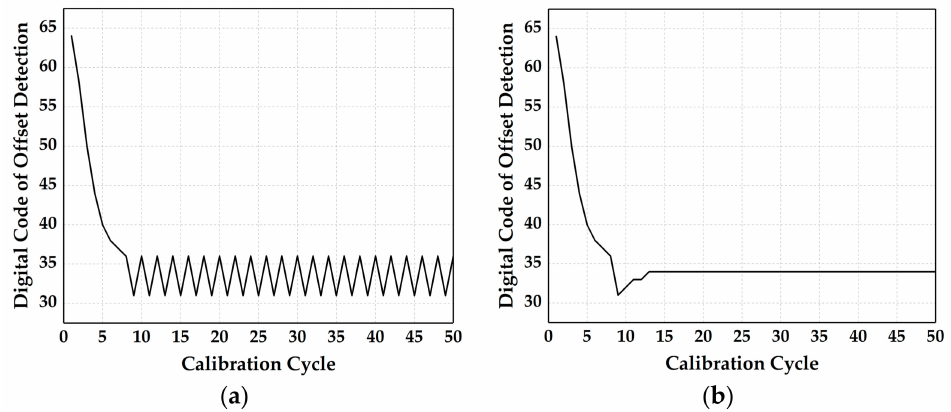
Figure 10. Simulated the calibration convergence of ( a ) non-ideal 7-bit current-steering DAC and ( b ) non-ideal 8-bit redundant current-steering DAC based on proposed